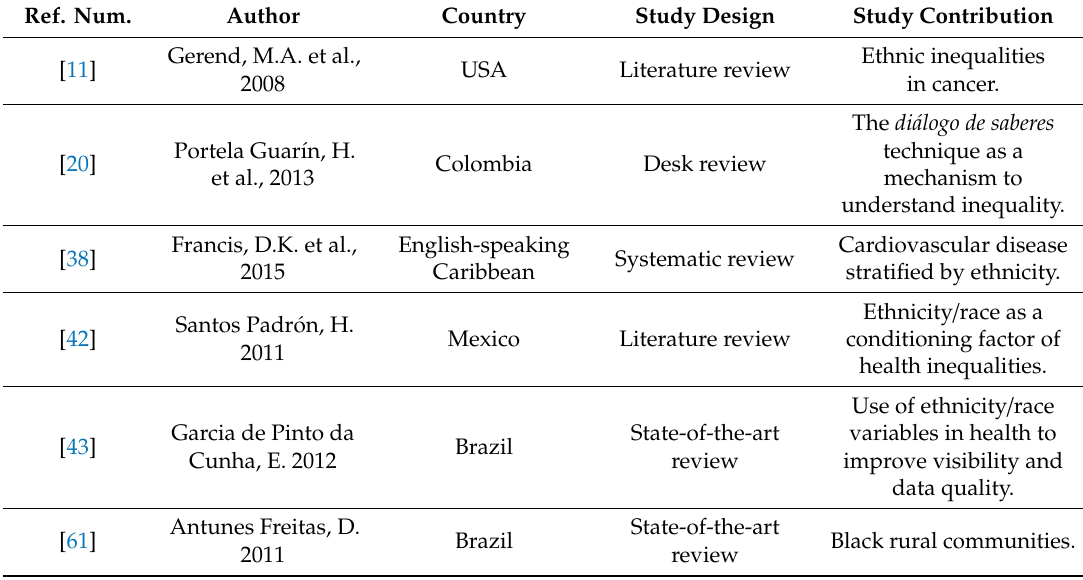
Table 3. Review articles